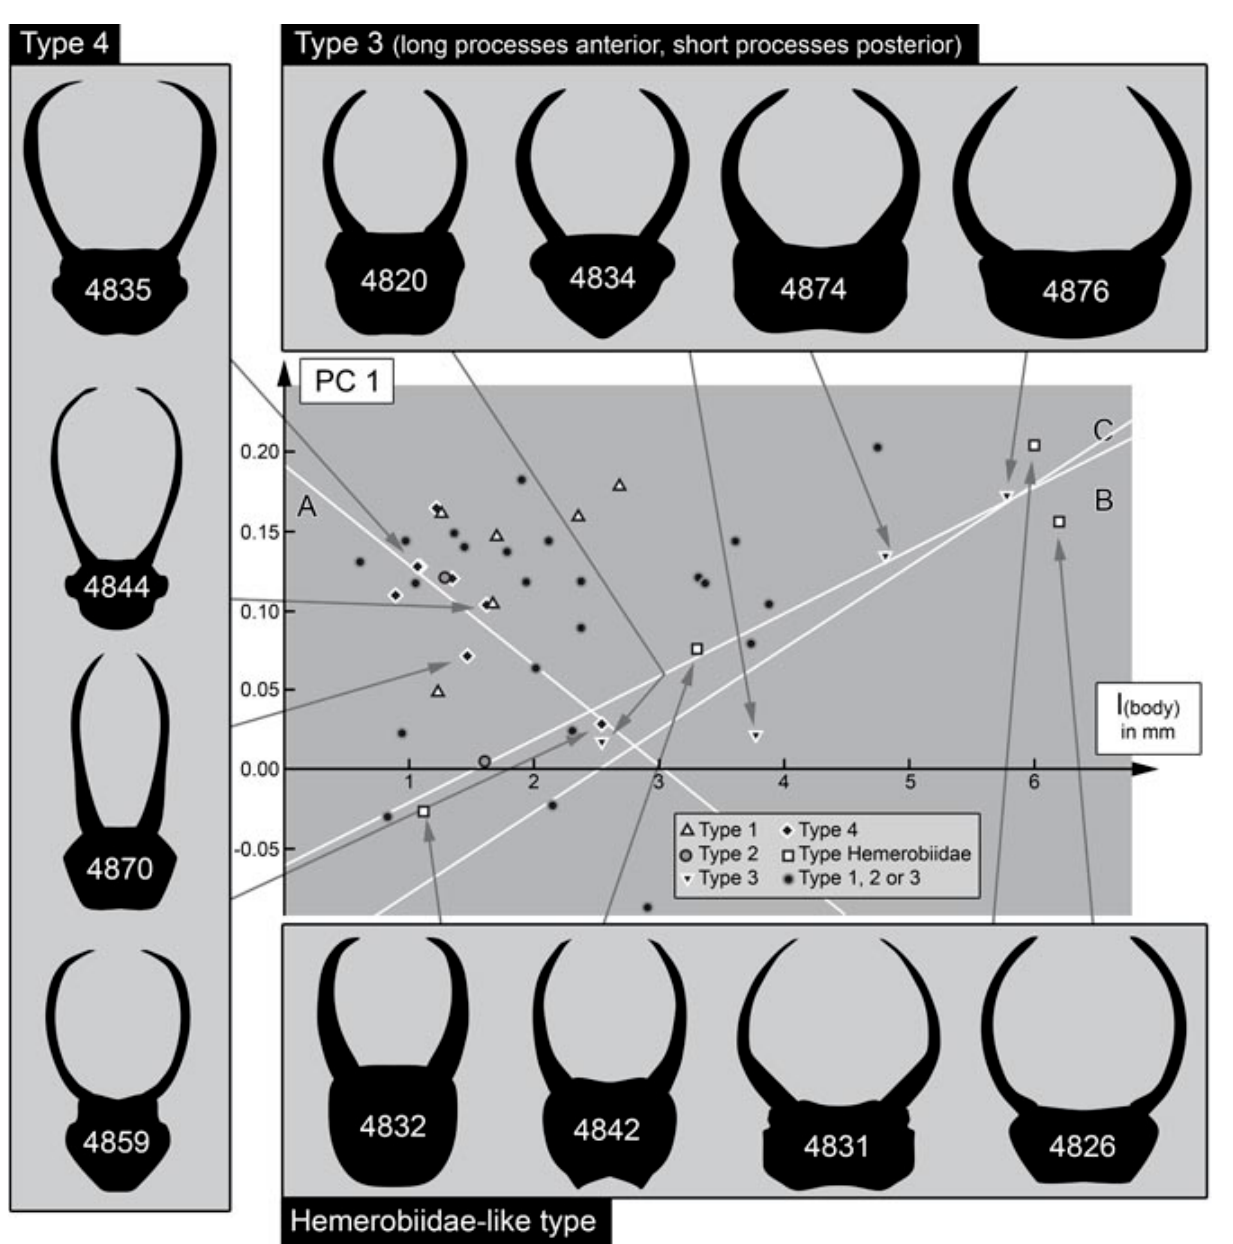
Figure 51. Scatter plot of PC1 vs. size. When distinguishing types, ontogenetic trajectories become apparent. Type 4 exhibits an ontogenetic change from broader heads to narrower ones. Type 3 and Hemerobiidae-like type exhibit an ontogenetic change from narrower heads to very broad heads.